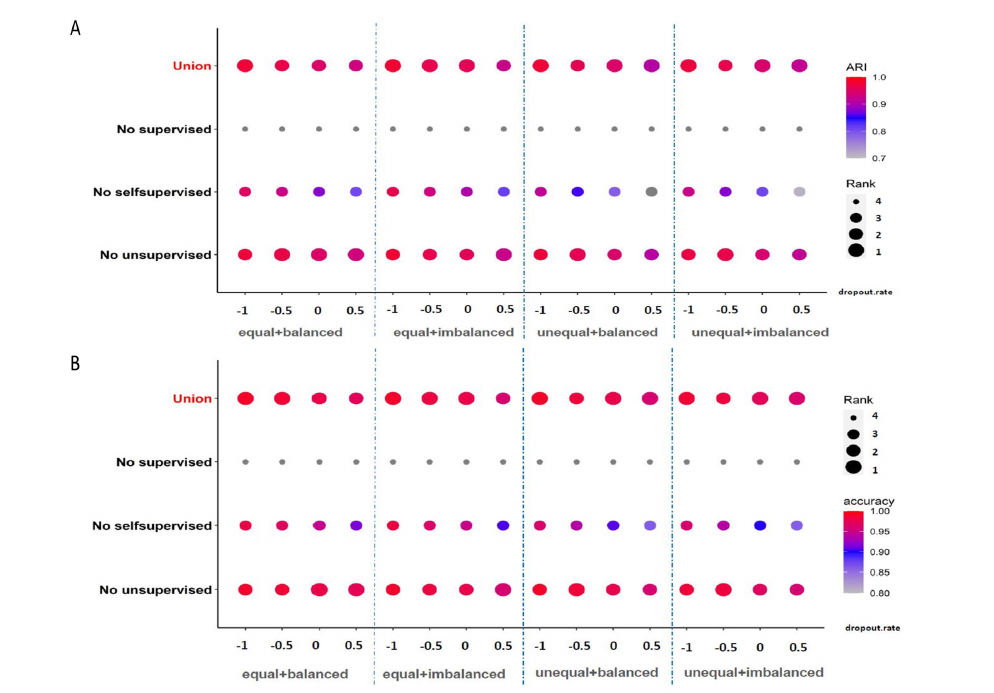
Figure 7. Ablation study on the simulation datasets. ( A , B ) Bubble plots of ARI and annotation accuracy values for scAnCluster in four groups of combining learning strategies,